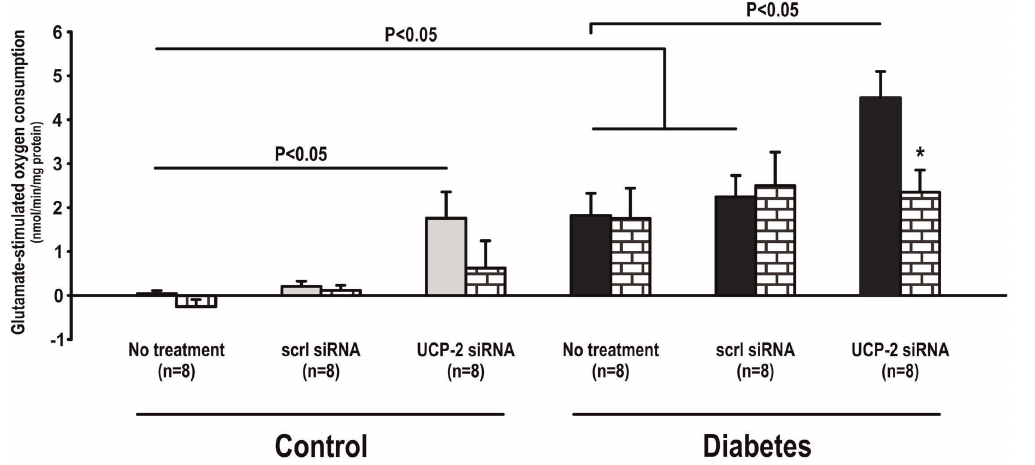
Figure 4. Mitochondria uncoupling measured as glutamate-stimulated O 2 consumption during inhibition of the ATP-synthase with oligomycin during baseline (filled bars) and after inhibition of ANT with ADP (patterned bars) in control and diabetic animals with and without scrambled or UCP-2 siRNA. * denotes p , 0.05 vs. baseline within the group.